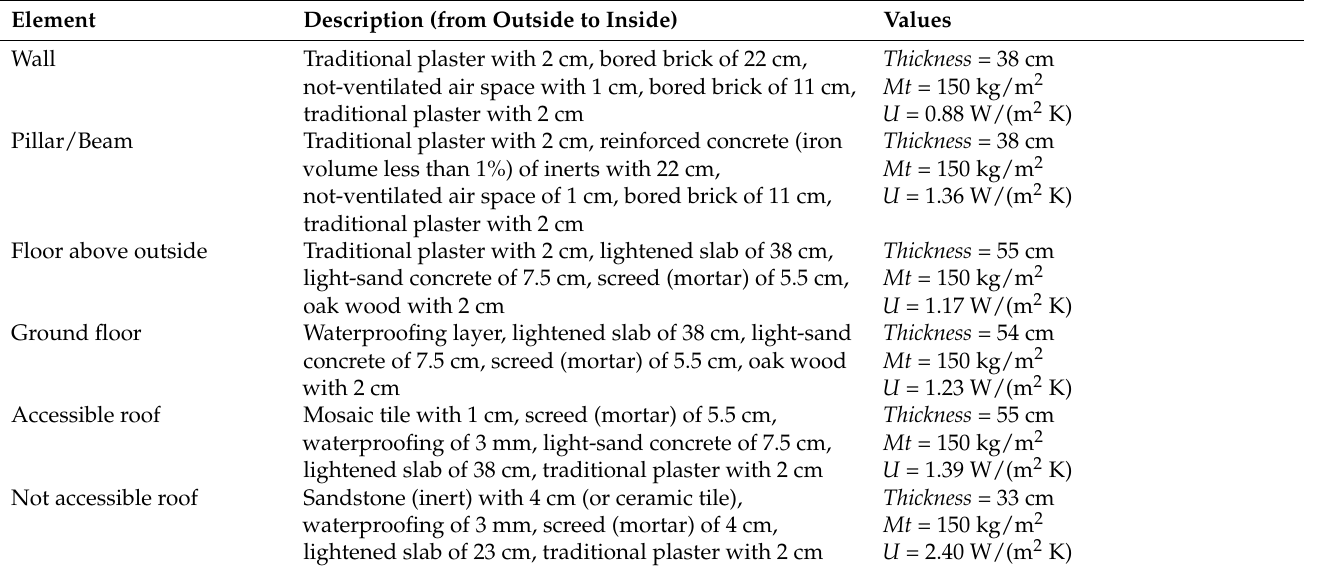
Table 4. Base structure of the opaque elements of the external